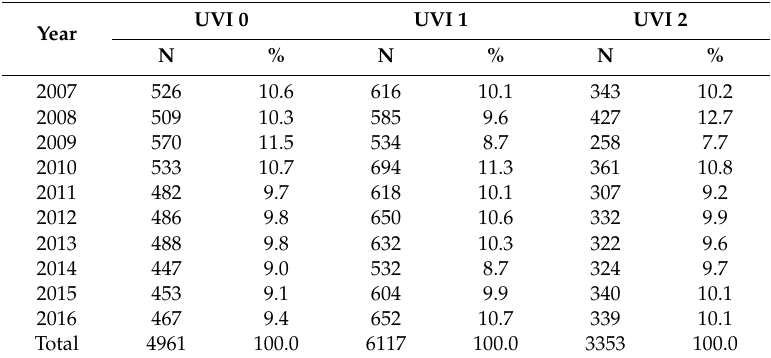
Table 2. Absolute (N) and relative (%) frequency distributions of UVI 0, 1, and 2 days, according to year of occurrence.